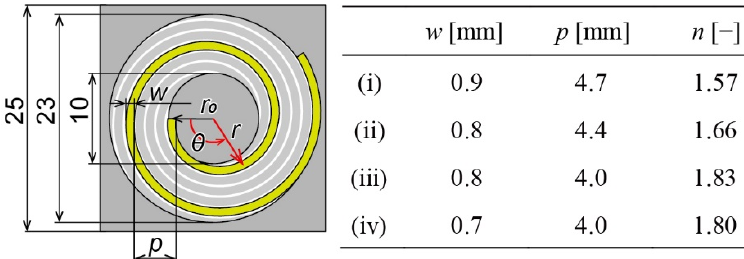
Figure 2. Detailed design and parameters of four types of force plate.